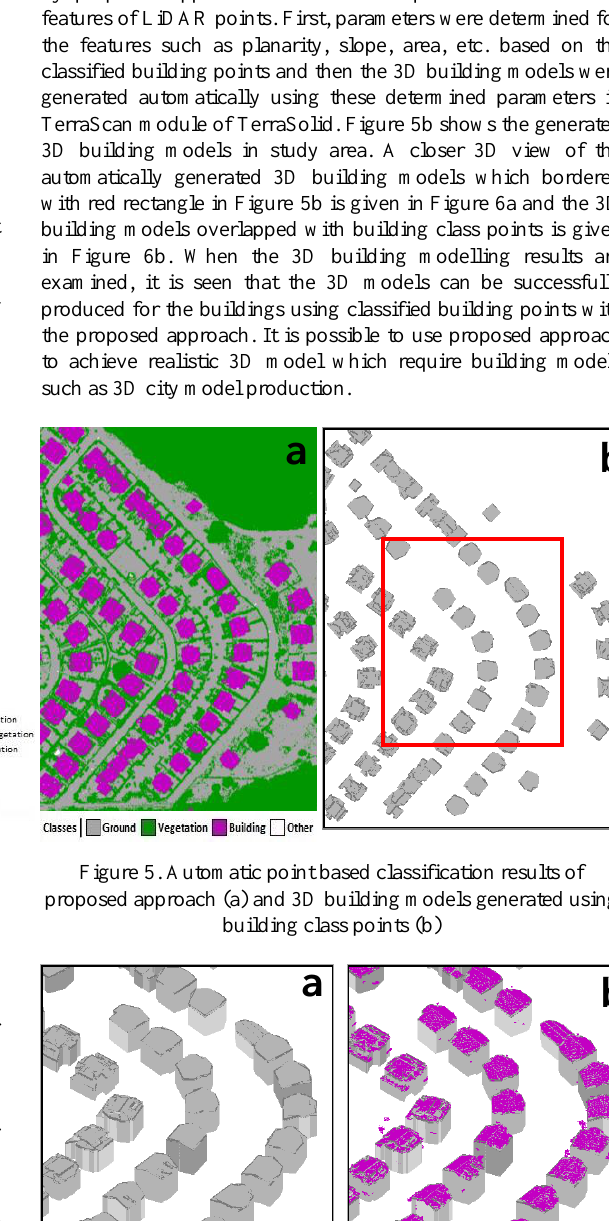
Figure 3. Ortho image of the selected pilot area 2, the classification results without (b) and with (c) parameter analyses